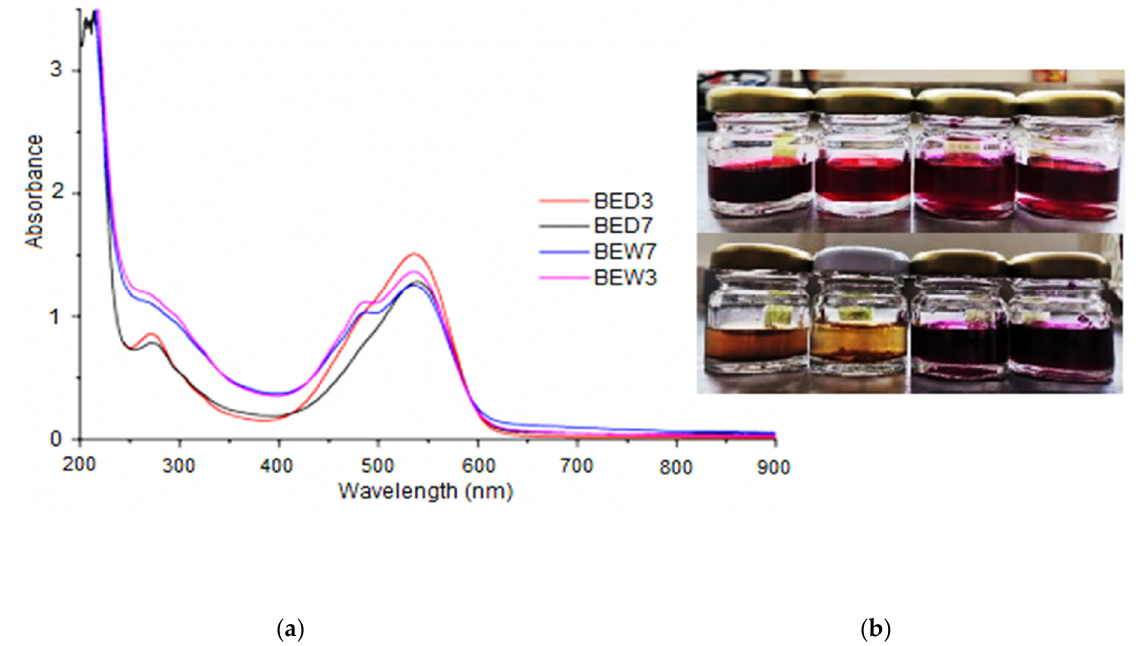
Figure 3. ( a ) UV–Vis spectra of extracts of beet by DES (2:1) pH 7 (BED7) and pH3 (BED3), and water extracts at similar pH (BEW3 and BEW7); ( b ) images of water and DES extracts from beetroot wastes (higher to lower), BW3, BW7, BED3, and BED7, at initial and final time of the test degradation of betalains (40 days).